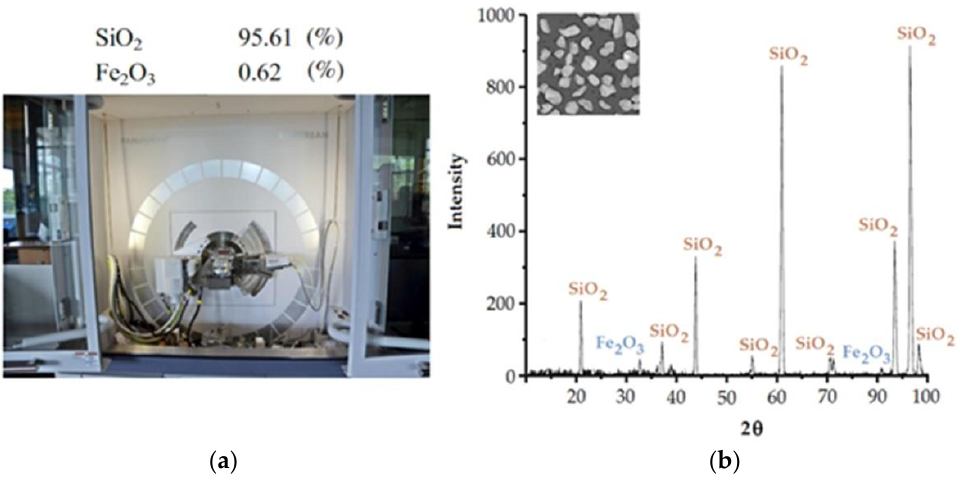
Figure 2. ( a ) X-ray diffractometer and ( b ) XRD spectrum of silica sand.